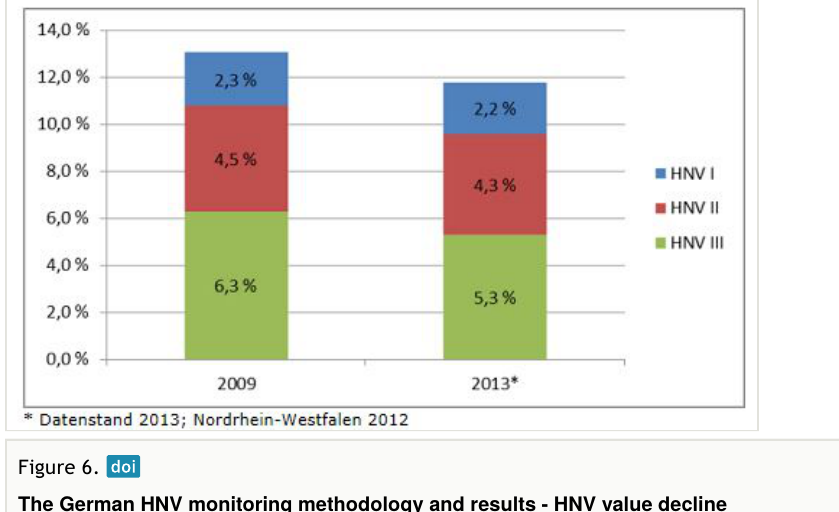
The German HNV monitoring methodology and results - HNV value decline In Germany, the HNV monitoring methodology has enabled an initial assessment of the trend in HNV value of farmland. Between 2009 and 2013, there was a signi fi cant decline of HNV value, in particular in the HNV class III, which represents the lowest value (in terms of species richness and structure). Graph reproduced from (Benzler et al. 2015).